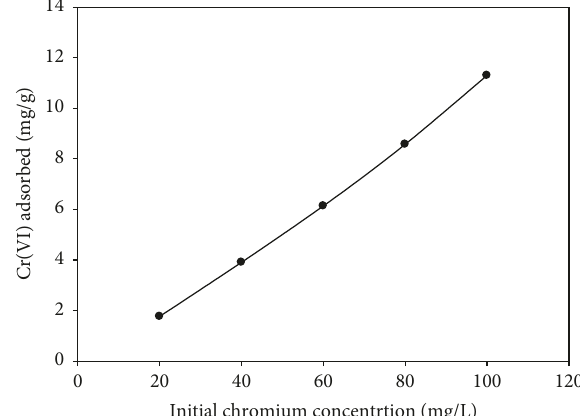
Figure 6: Effect of initial chromium concentration. pH 7 (cid:31) 10mg/L. (cid:31)